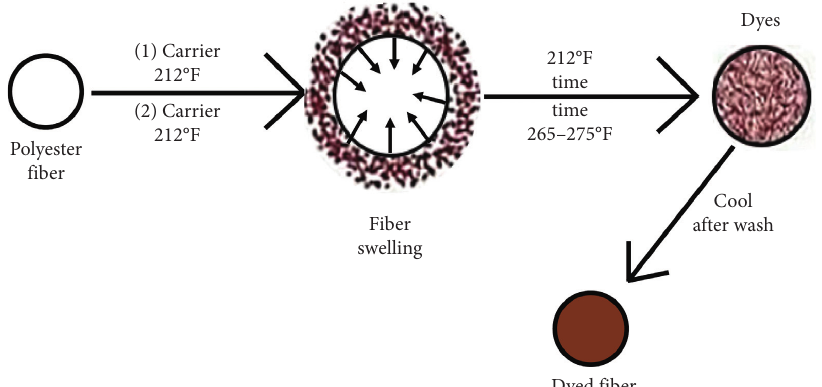
Figure 3: Representation of the mechanism of the aqueous phase transfer of dispersed dyes to hydrophobic